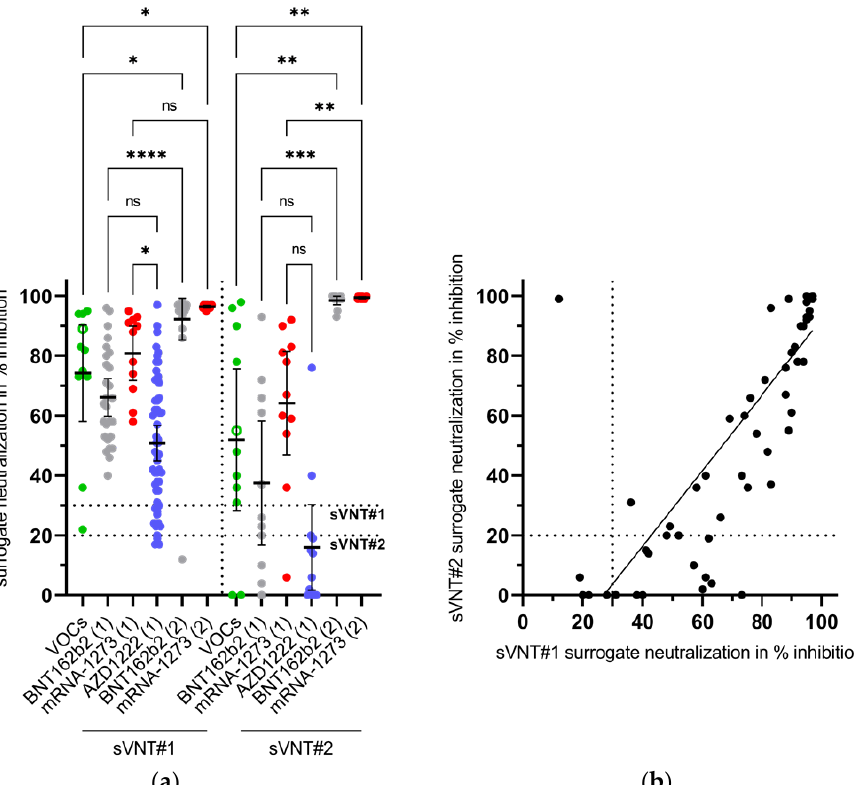
Figure 4. ( a ) Investigation of convalescent sera (after infection with SARS-CoV-2 variants of concern, VOCs) and of vaccinees sera in two surrogate virus neutralization tests (sVNT #1 and #2). These assays measure the antibody-mediated prevention of the binding of the viral receptor-binding domain to the angiotensin-converting enzyme 2. The degree of binding inhibition is given as a percentage and is taken as an indication of the presence of virus-neutralizing antibodies. The mean and the 95% confidence interval are given for each group of patients (VOCs: B.1.1.7 filled green dots; B.1.351 empty green dot) or vaccinees after first (1) or second (2) vaccination with messenger ribonucleic acid (BNT162b2; mRNA-1273) or vector vaccines (AZD1222), respectively. Horizontal dotted lines indicate the cut-offs of both assays. Data were valued for statistical significance by a non-parametric, unpaired, and adjusted test (Kruskal-Wallis test). Ns: not significant; *: p < 0.05; **: p < 0.01; ***: p < 0.001; ****: p < 0.0001. ( b ) Quantitative agreement between both sVNTs. The Spearman correlation coefficient was calculated with 0.89. Table 3. Qualitative agreement of results obtained with both surrogate virus neutralization tests (sVNT).